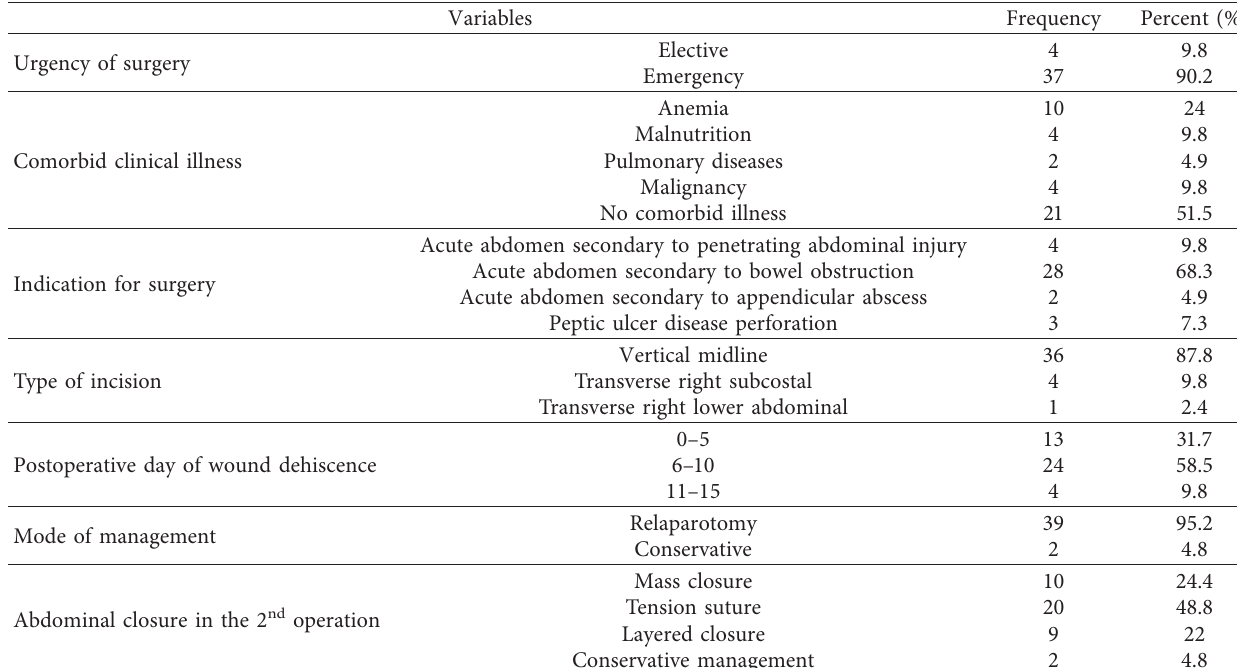
Table 2: Description of clinical factors among patients who developed abdominal wound dehiscence during September 2014 to September 2017 at SPHMMC, Addis Ababa, Ethiopia ( n �